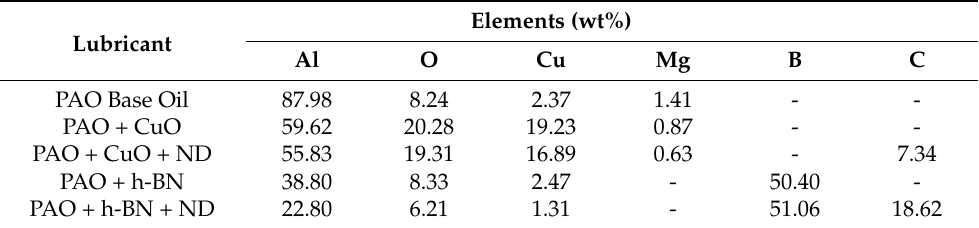
Table 4. Average percentage of elements (wt%) on Al alloy disc surfaces slid under PAO base oil and four nanolubricants, from EDS area analysis. The values are averages taken from analysis of five different area locations on each wear track of the slid Al alloy discs. Elements (wt%) Lubricant Al